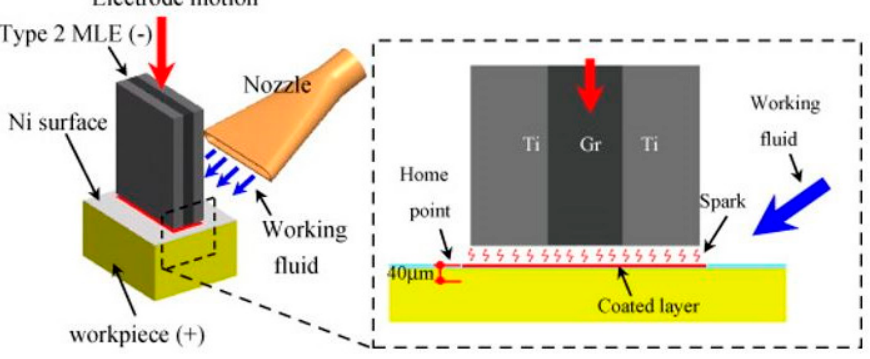
Figure 14. Schematic of TiC layer over the Ni workpiece by multi-layer electrode [95]. With the help of EDC, a TiC coating was developed to eliminate the defects by incor- poration of silicon debris. EDX maps in Figure 15a shows the Ti was present throughout the coating, as shown in SEM, though its distribution was not completely consistent. These different bulk structures were due to variation in the corrosion regime during the etching process. The wear resistance of both single and multi-layer coatings of TiC over stainless steel was evaluated with the assistance of ball-on-flat wear testing, which showed the best results of wear regardless of cracking left in the TiC single layer coating. The surface cracks were eliminated and worse friction was produced in a double coating of TiC + Si in compar- ison to TiC. The coating of TiC + Si resulted in zero porosity and negligible surface cracks, as illustrated in Figure 15b. The cross-sectional images of the TiC + Si double-layer show that cracking was completely removed as the lower melting point of Si than TiC, which resulted in the removal of the majority of the Si as it reaches the workpiece surface, owing to the explosive effect of discharge that prevents penetration inside the coating layer [148]. Recently, the mechanism of TiC coating that eliminates the defects by incorporation of Si debris was explained. Figure 16 shows the mechanism involved in improving the coating layer defect when Si as an electrode was used at the end of the coating. These low-density Si particles served in enhancing the gap width, as Si enhances the uni- formity and density distribution of its particles between the spark gaps. Due to this, bub- ble expansion became slower when there was a smaller gap. The process of resolidification and expulsion of the material becomes less intense; therefore, the composite coating layer has fewer cracks and pores with low surface roughness. Hence, the attenuation process of spark discharge through gap widening by Si debris resulted in excellent layer properties. They concluded that these coatings can be generated on components with complex sur- faces [149]. Table 7 shows the summary of the past literature work on EDC with a multi- layer electrode. Figure 15. Images of coating cross-sectional showing BSE and EDX maps of ( a ) TiC layer and ( b ) TiC + Si coating layer [148].